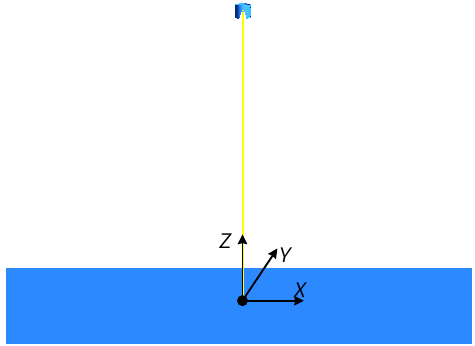
Figure 7. Coordinate system of the near-wall flow field.